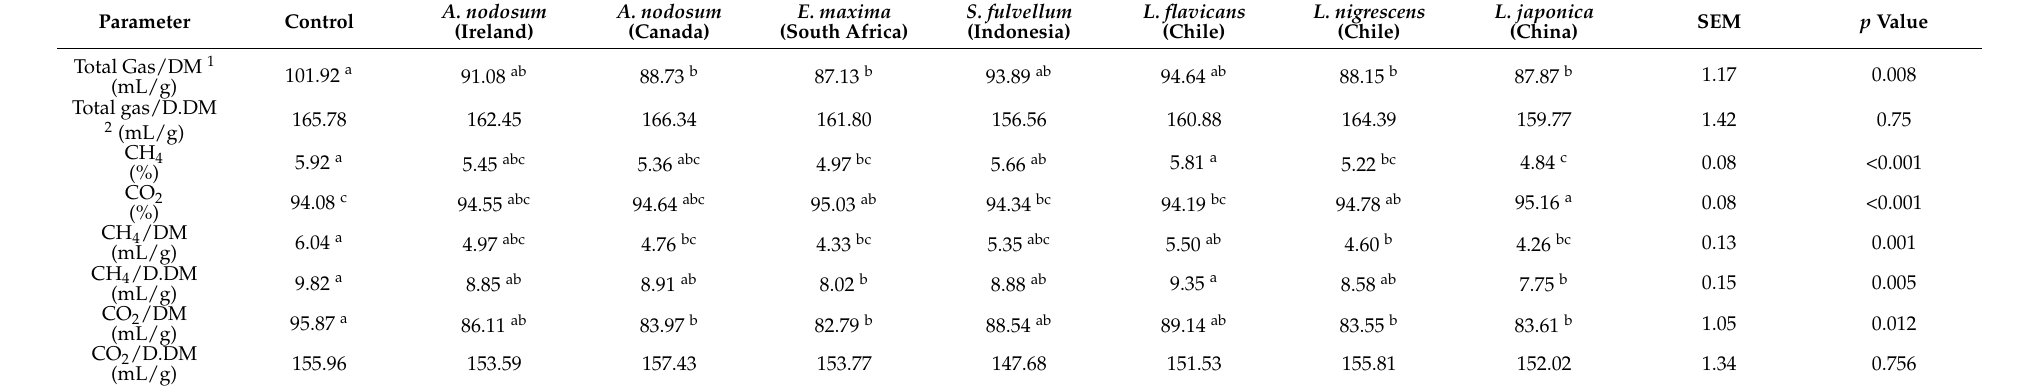
Table 6. Effect of different brown seaweeds as feed on gas production profile from 24 h in vitro incubation ( n = 4) (Experiment 2). Parameter